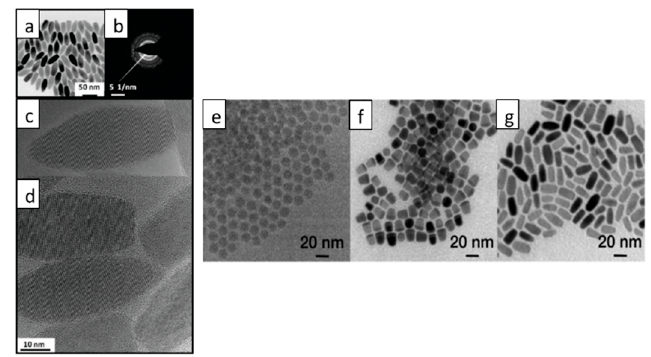
Figure 4. Transmission Electron Microscope (TEM) images of typical Cu-based ternary nanorod structures, ( a – d ) TEM images of CIS NRs with the hot-injection method. Reproduced with permission from [112]. Copyright American Chemical Society, 2010. ( e – g ) TEM images of CIS NRs with the hot-injection method. Reproduced with permission from [113]. Copyright American Chemical Society, 2014.